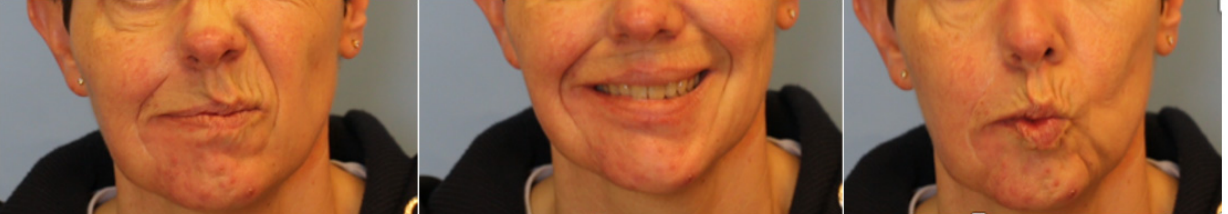
tional outcome after the reanimation of the lower face with a micro-neurovascular anas- tomosed gracilis muscle flap, supplied by the masseteric nerve. Five patients with long- standing FP, who underwent the surgery between June 2019 and October 2020, were consecutively followed up over the time period of one year. The time course of the gracilis graft reinnervation was observed clinically, and was examined using a needle